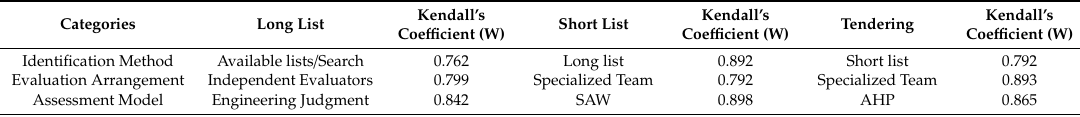
Table 7. Proposed procedures of evaluation of Construction General